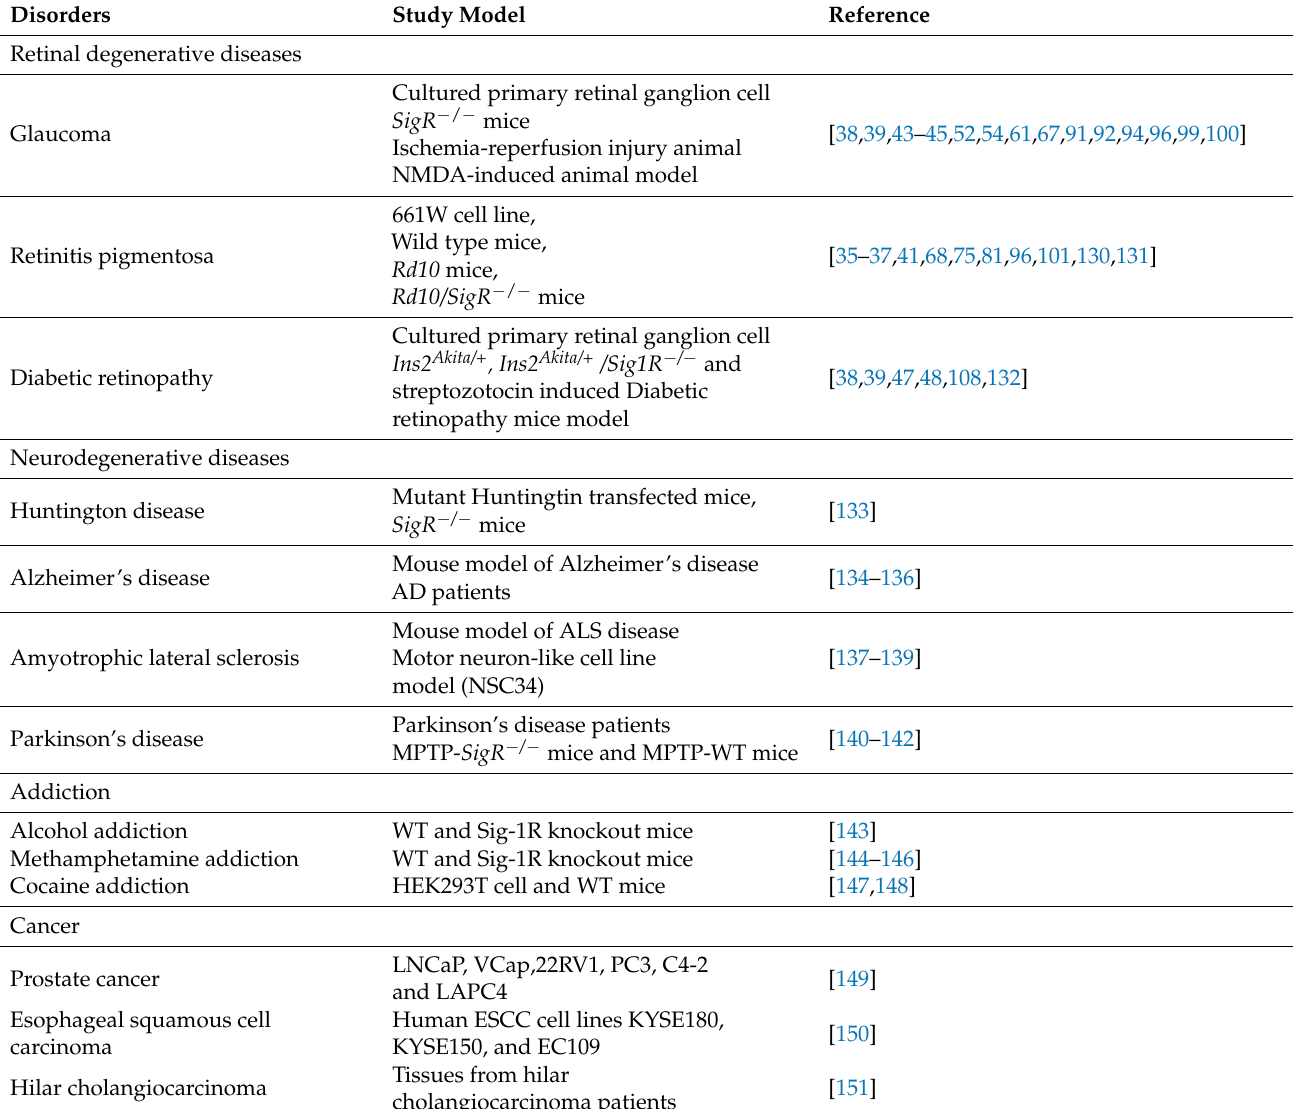
Table 2. Sigma-1 receptor relevant